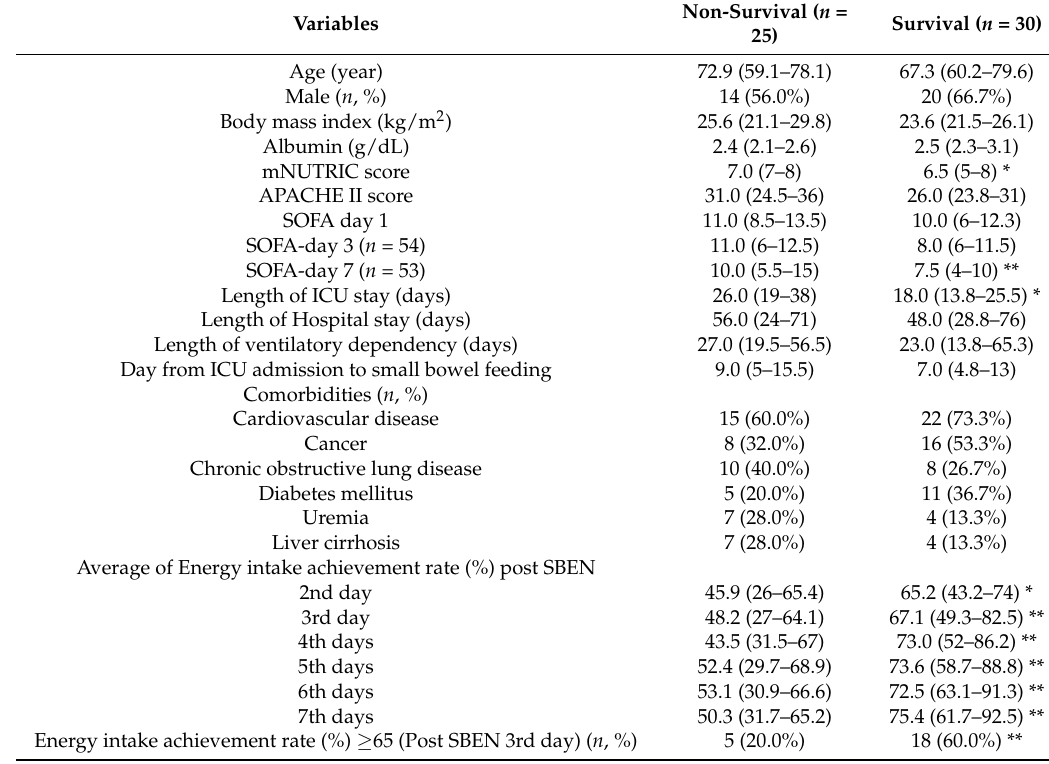
Table 3. Patient demographic characteristics, severity index, comorbidities, and energy intake achievement rates in survivors and